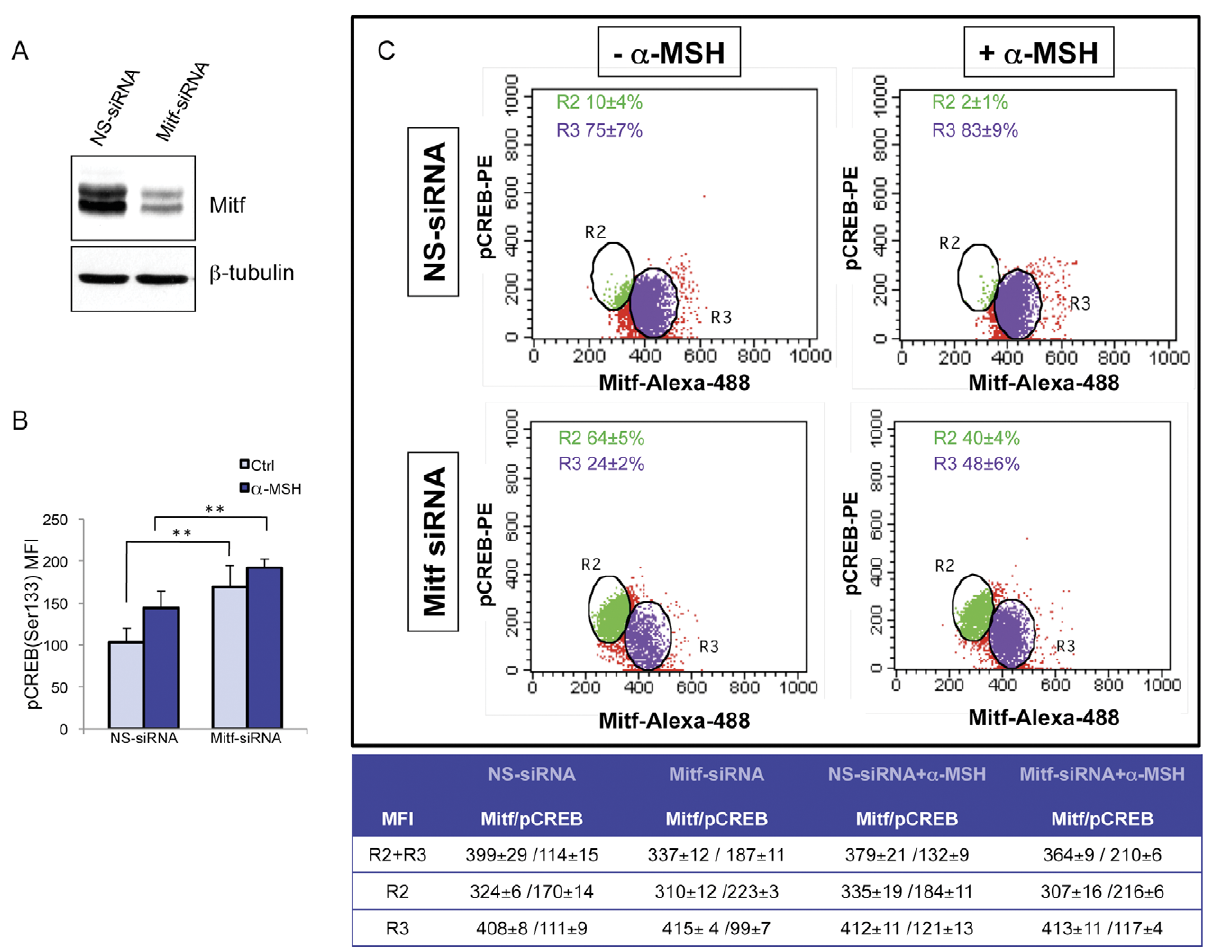
Figure 4. Coordinated regulation of Mitf expression and CREB activation. (A) One representative western blot anti-Mitf used to quantify RNA interference efficiency after 24 h of nucleofection. (B) Analysis of Mitf siRNA interference on CREB level of phosphorylation was analyzed measuring CREB level of phosphorylation by measuring PE-CREB-Ser133 median fluorescence intensity (MFI) in duplicates. Histogram represents means 6 SD of MFI of three independent experimets. (C) Dot plot analysis of one representative experiments of Mitf-siRNA showing higher MFI of PE- CREB-Ser133 in samples presenting low levels of Mitf expression (region R2) in comparison with the cell fraction presenting high levels of Mitf (region